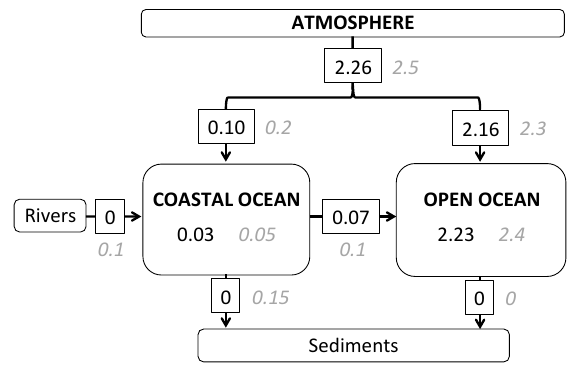
Figure 9. Transfer of anthropogenic carbon between the atmo- sphere, coastal ocean, and open ocean along with increases in the corresponding inventory in each reservoir, given as the average of simulated values over 1993–2012. All results are in PgCyr − 1 . Sim- ulated results are shown as dark numbers in boxes and adjacent numbers (grey italic) indicate data-based estimates for the 2000– 2010 average (Regnier et al.,